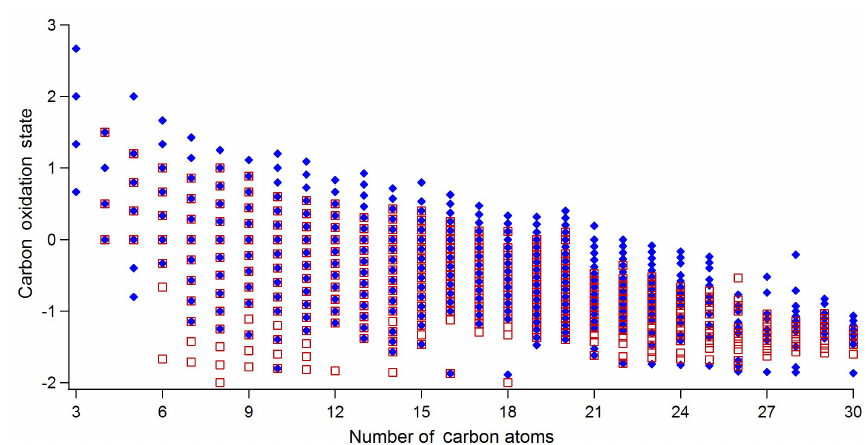
Figure 3. Carbon oxidation state plot for CHO-containing formulae in organic aerosol from IOP1 (red squares) and IOP2 (blue diamonds).